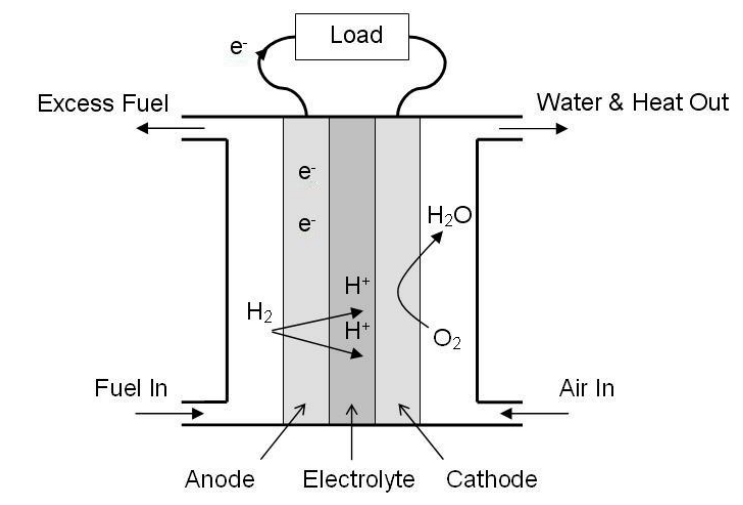
Figure 4. Example of a polymer electrolyte membrane (PEM) fuel